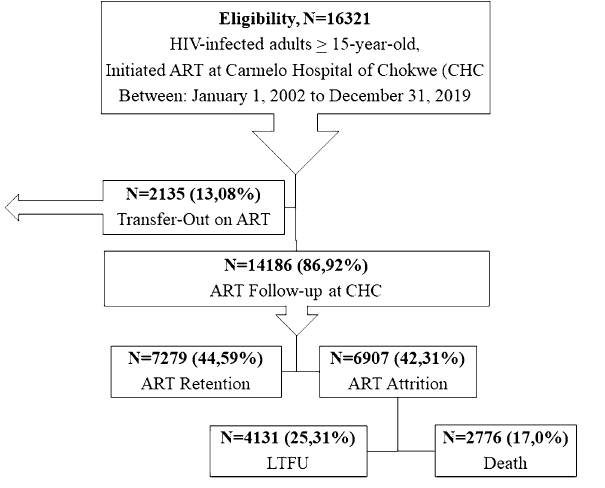
Figure 2. ART outcomes among PLWHIV at Carmelo Hospital of Chókwè (2002–2019), N =